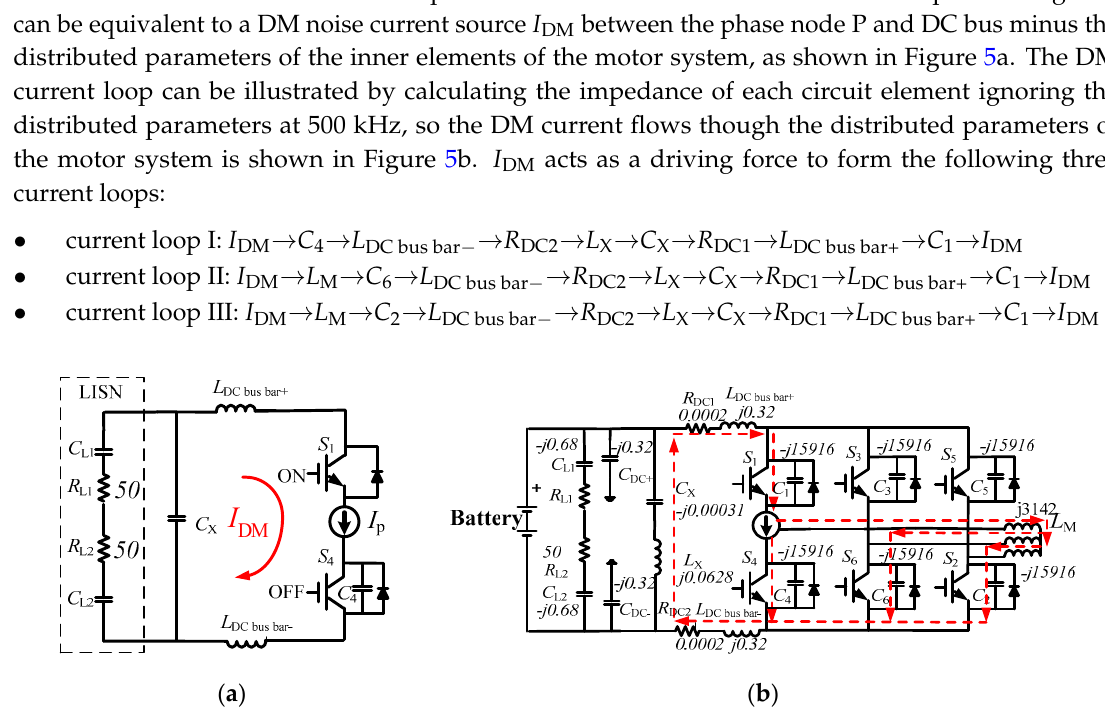
Figure 5. ( a ) Equivalent circuit for DM; ( b ) DM interference propagation path at 500 kHz.